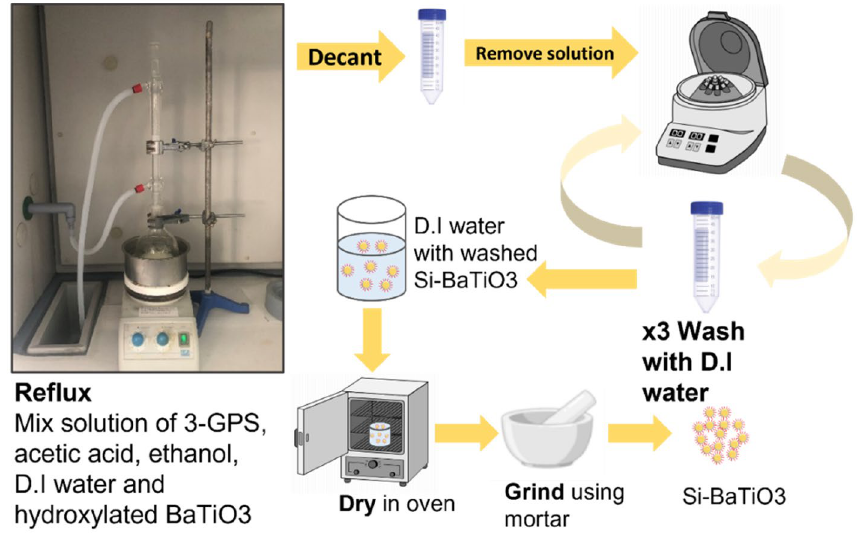
Figure 7. Schematic diagram of the functionalisation process of BaTiO 3 with